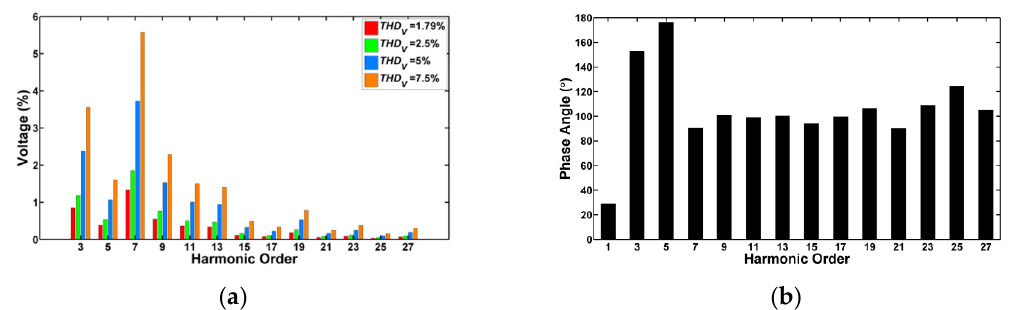
Figure 2. Harmonics spectra of the supply voltage ( a ) used during measurements and ( b ) their phase angle. Table 1. Summary of the measured values of the electrical parameters of the lighting luminaires marked as LUM1.